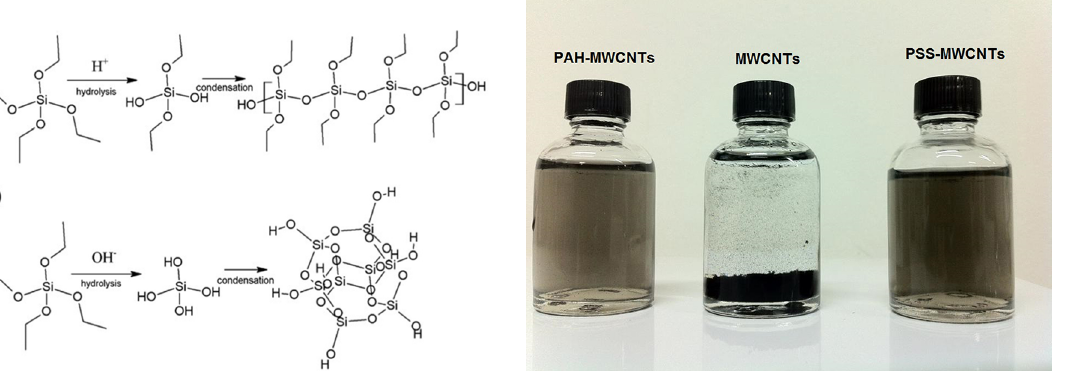
Figure 4. Photographs of aqueous dispersions of MWCNTs, PAH- MWCNTs and